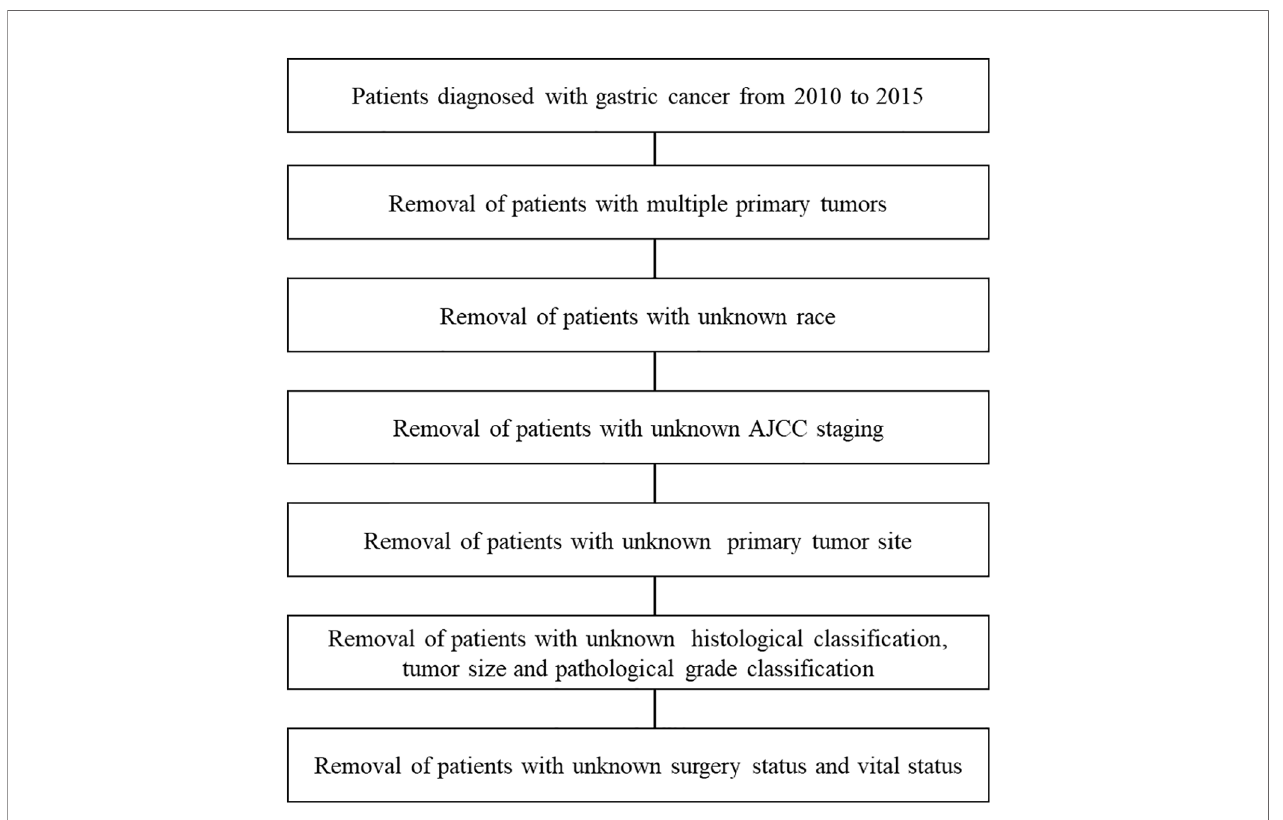
FIGURE 1 | CONSORT diagram. AJCC, American Joint Committee on Cancer, 7th edition.